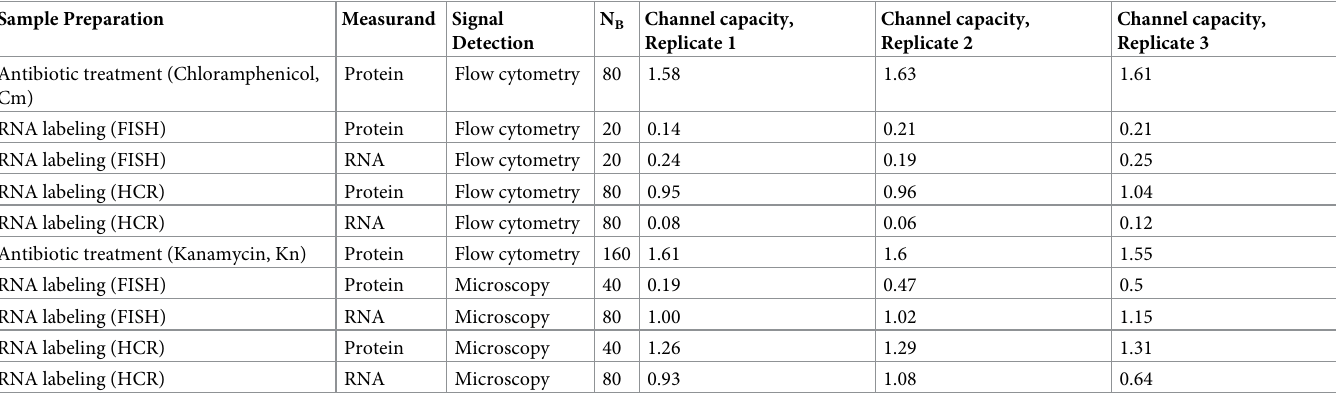
Table 2. Detailed information for analysis and results from each method and